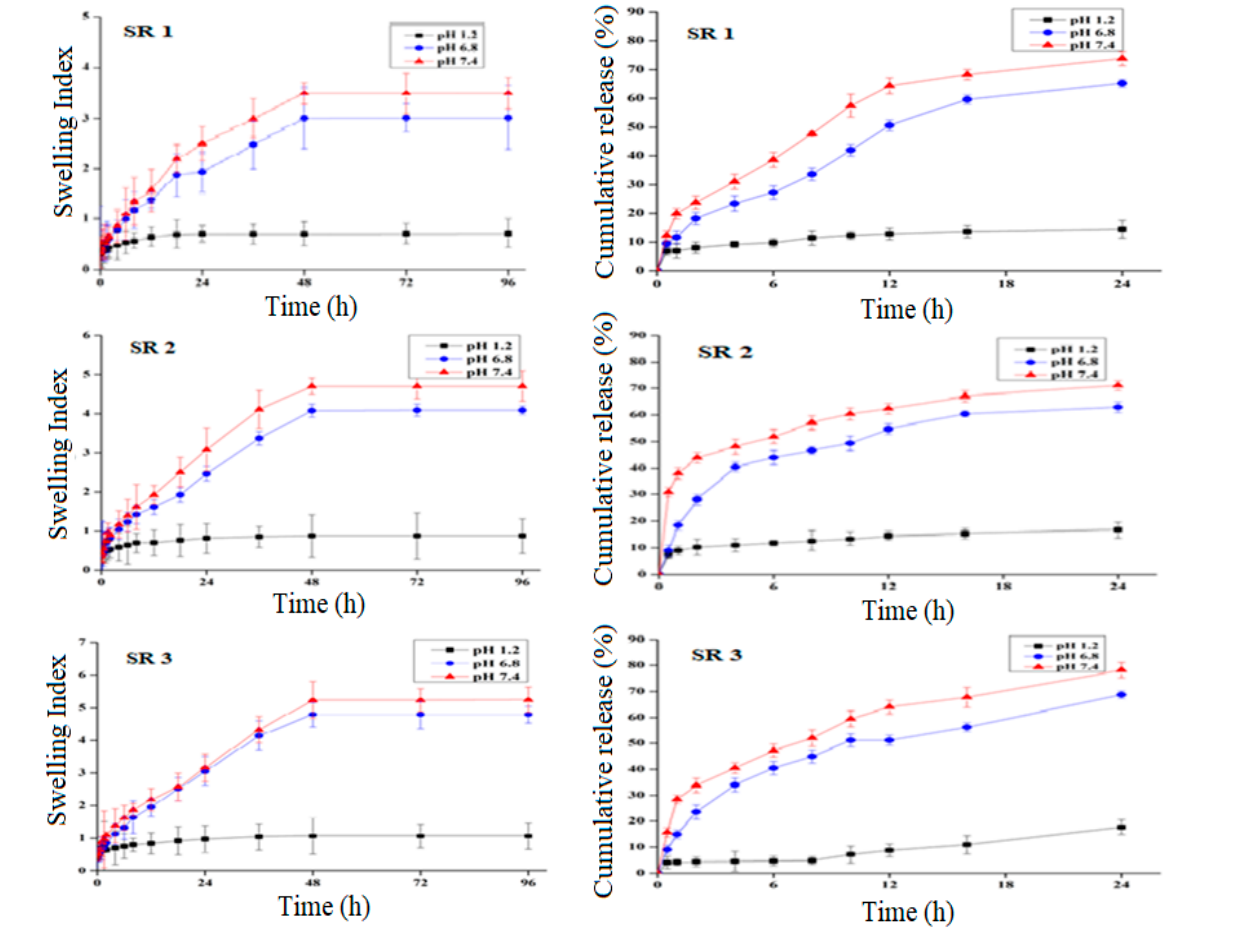
Figure 3. Swelling ratio and percentage drug release of formulation SR1-SR3.